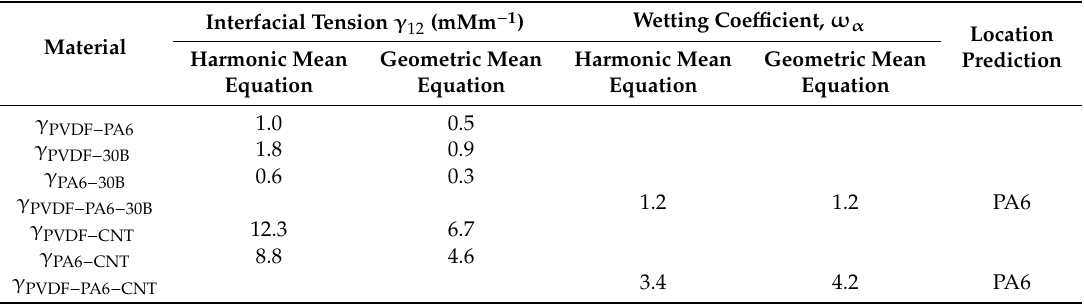
Table 2. Interfacial tensions and wetting coe ffi cients according to the geometric mean and harmonic mean